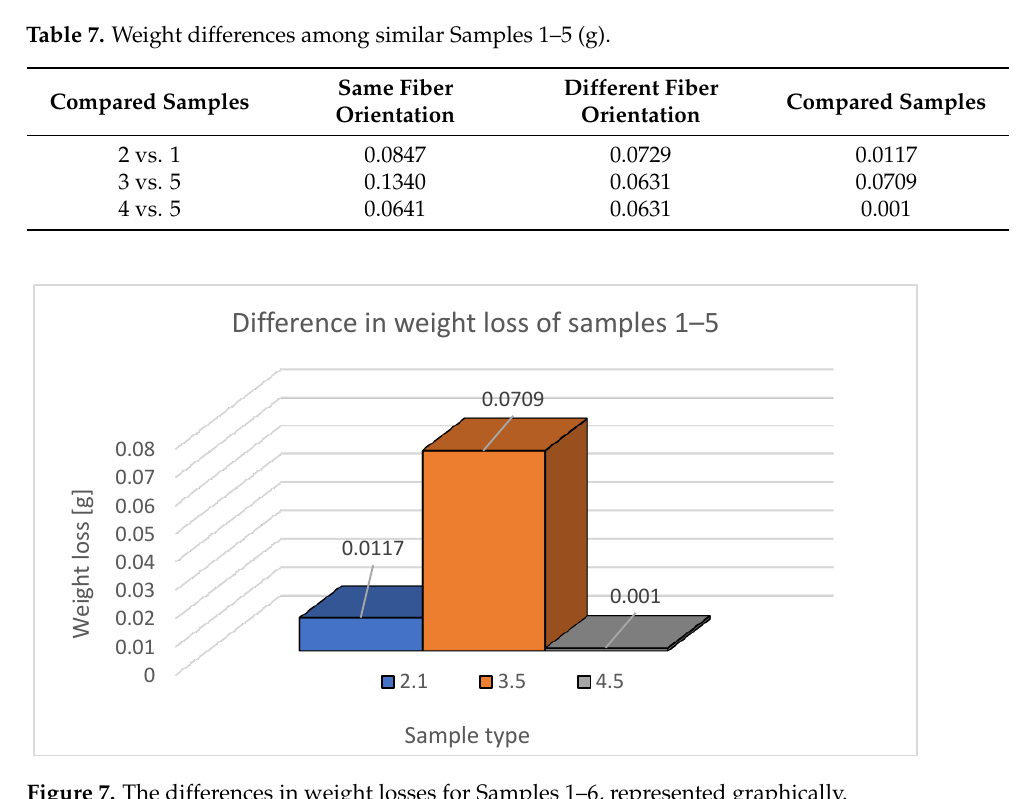
Figure 7. The differences in weight losses for Samples 1 – 6, represented graphically.